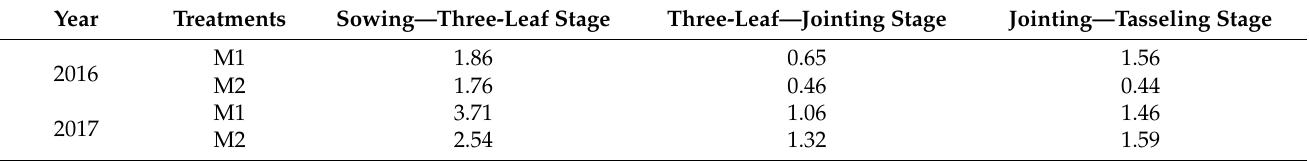
Table 10. Compensatory coefficient for accumulated air temperature of plastic film